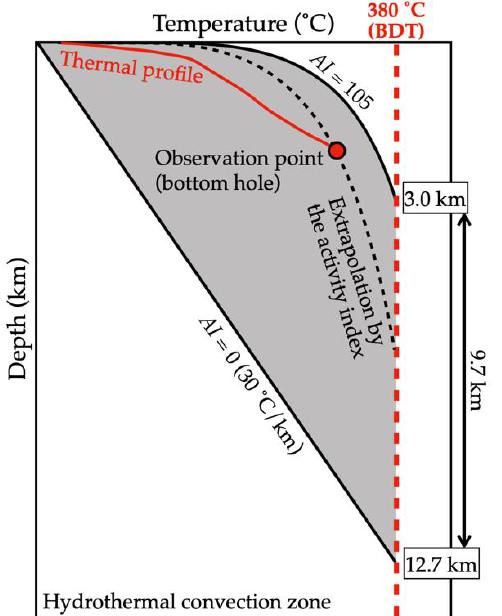
Figure 9. Extrapolation range for subsurface thermal structure in geothermal fields estimated from the conceptual model based on the activity index.